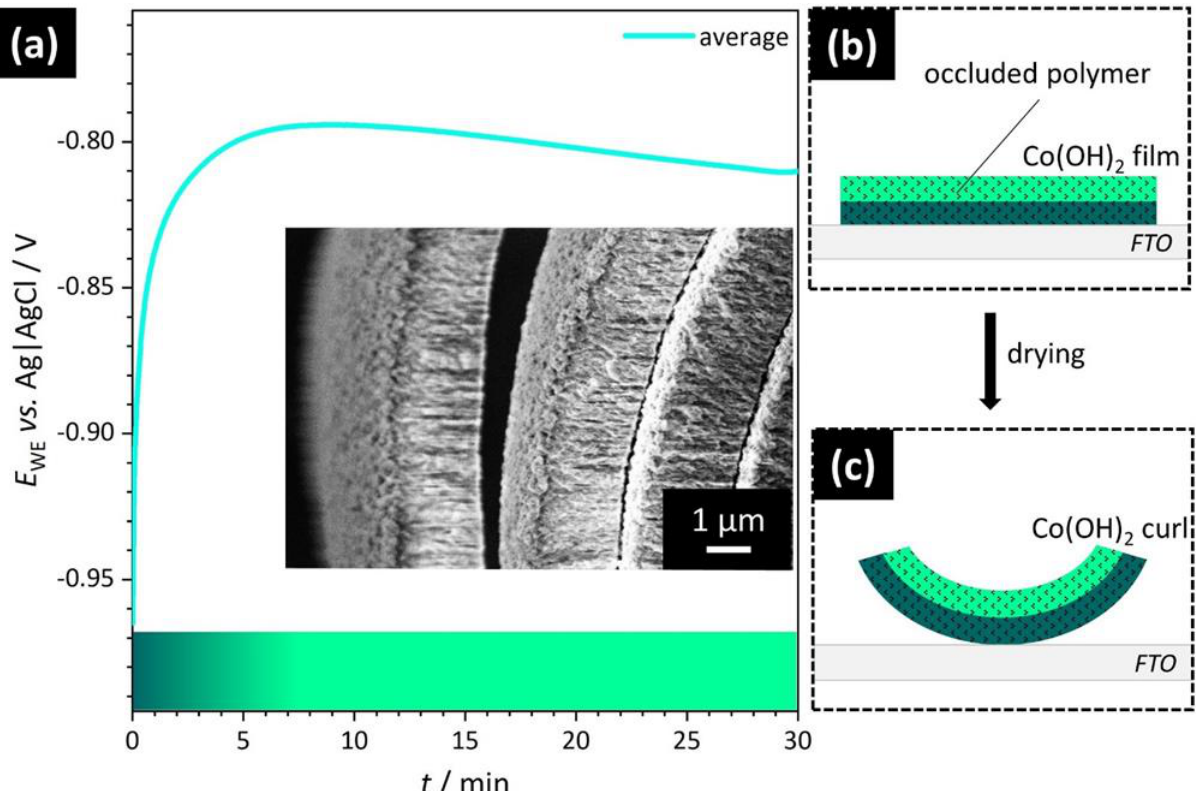
Figure 6. Proposed mechanism of hybrid organic–inorganic microscrolls. ( a ) Potential profile during CED experiments as a function of deposition time. The initially more negative potential early in the CED process results in a higher driving force for precipitation, leading to the formation of a poorly ordered Co(OH) 2 layer (dark green) directly in contact with the substrate surface. Subsequently, a layer comprising well-ordered structural features (light green) is nucleated, presumably due to the gradually increasing structure-directing effect of the polyelectrolyte at increasingly less negative deposition potentials. The color bar at the bottom represents the formation of structurally distinct layers. Inset: SEM of a microscroll cross-section featuring several turns of the spiral structure. While the convex surface of the film was in contact with the electrode prior to dewetting, the concave side was exposed to the solution. ( b ) Schematic illustration of a flat Co(OH) 2 film attached to the FTO substrate prior to the drying and dewetting process. A structurally non-uniform bilayer arrangement with occluded polymer in both layers is depicted. ( c ) Schematic illustration of a bent film as a result of a different response of structurally distinct sublayers to the release of intrastructural water.